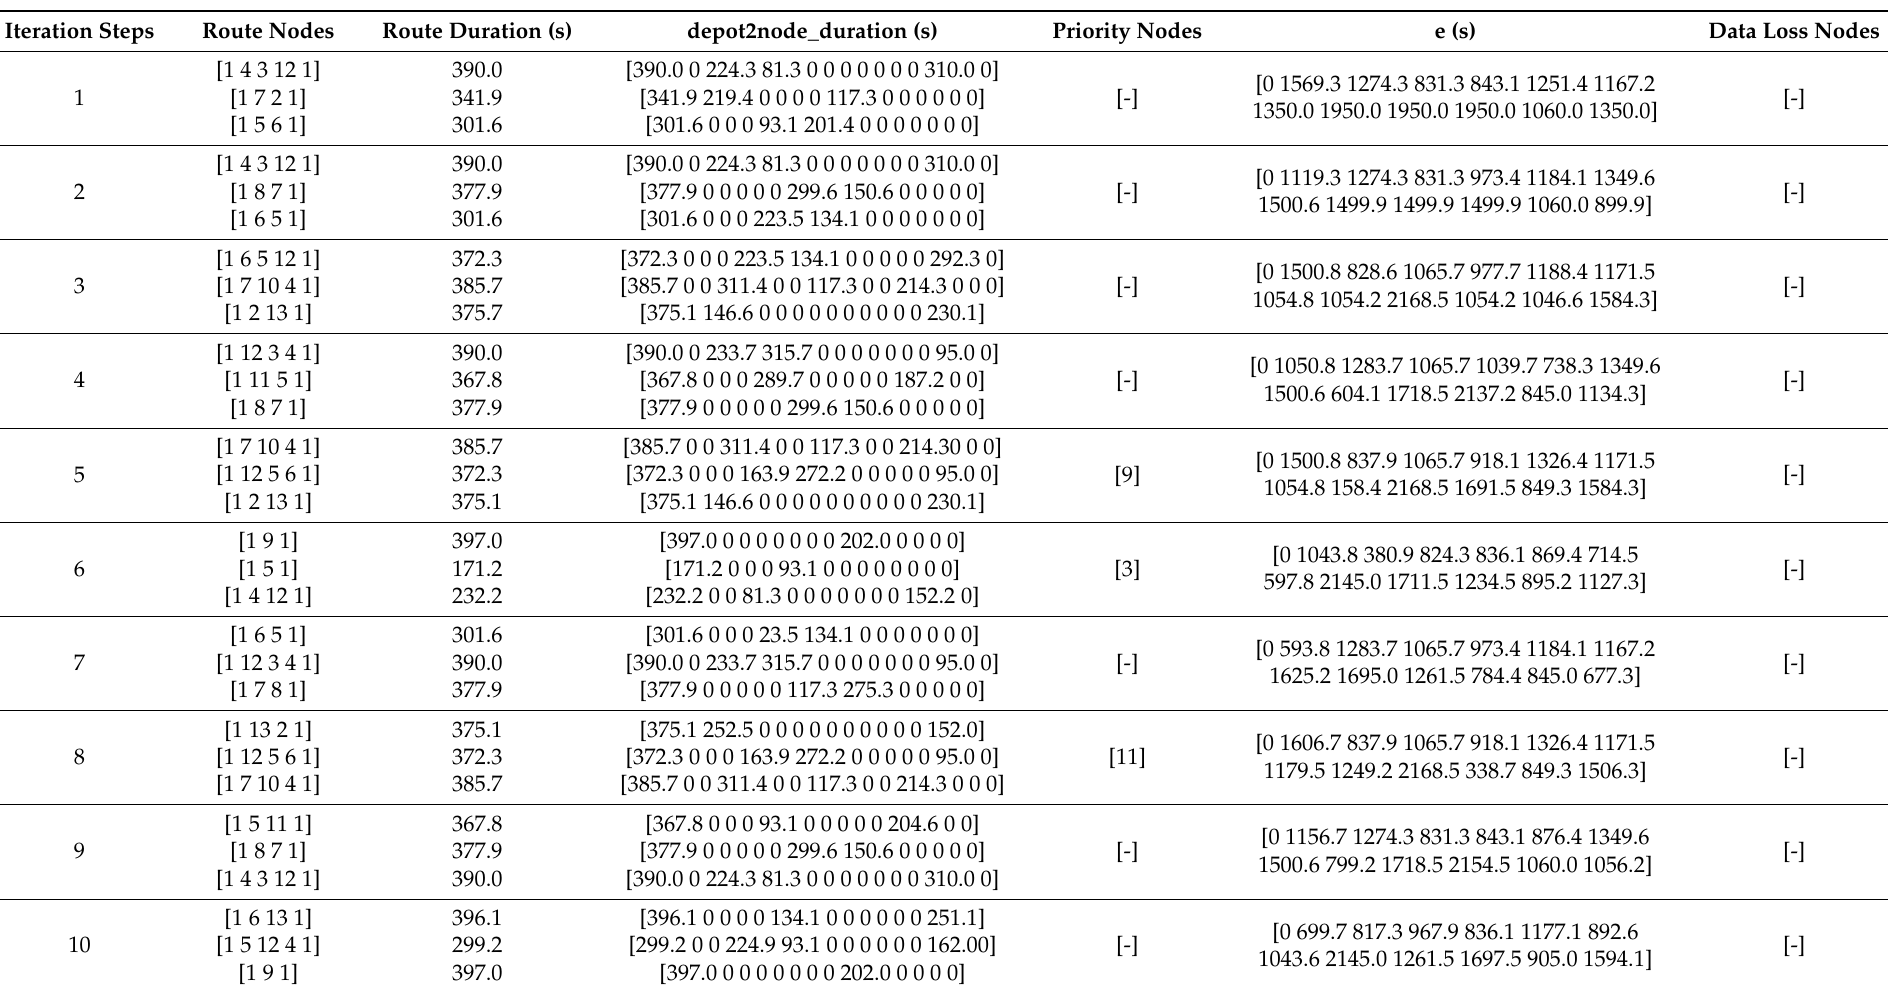
Table 3. MES Routes Results for 13 Nodes and 3